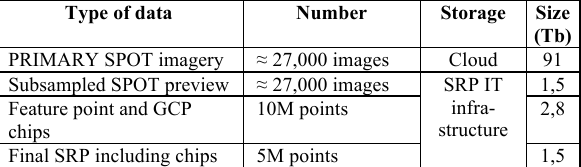
Table 2: Size of the data for the European